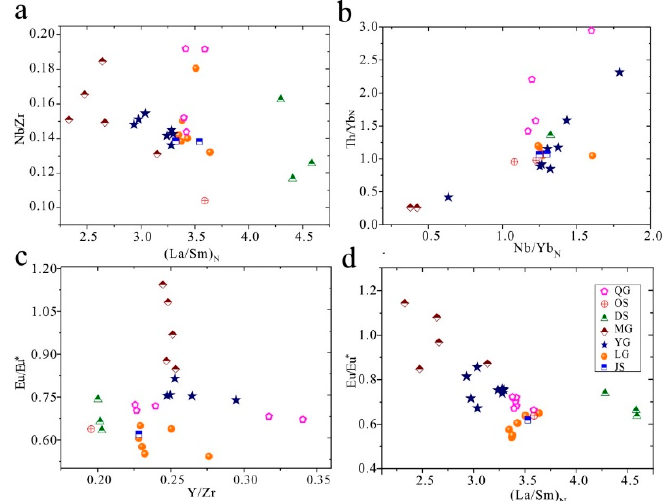
Figure 3. Bivariate plots and spatial distributions of geochemical compositions of snow dust and cryoconite samples from the glaciers and snowpacks in the Tianshan Mountains and northeast Tibetan Plateau. ( a ) (La/Sm) N versus Nb/Zr; ( b ) Nb/Yb N versus Th/Yb N ; ( c ) Y/Zr versus Eu/Eu*; ( d ) (La/Sm) N versus